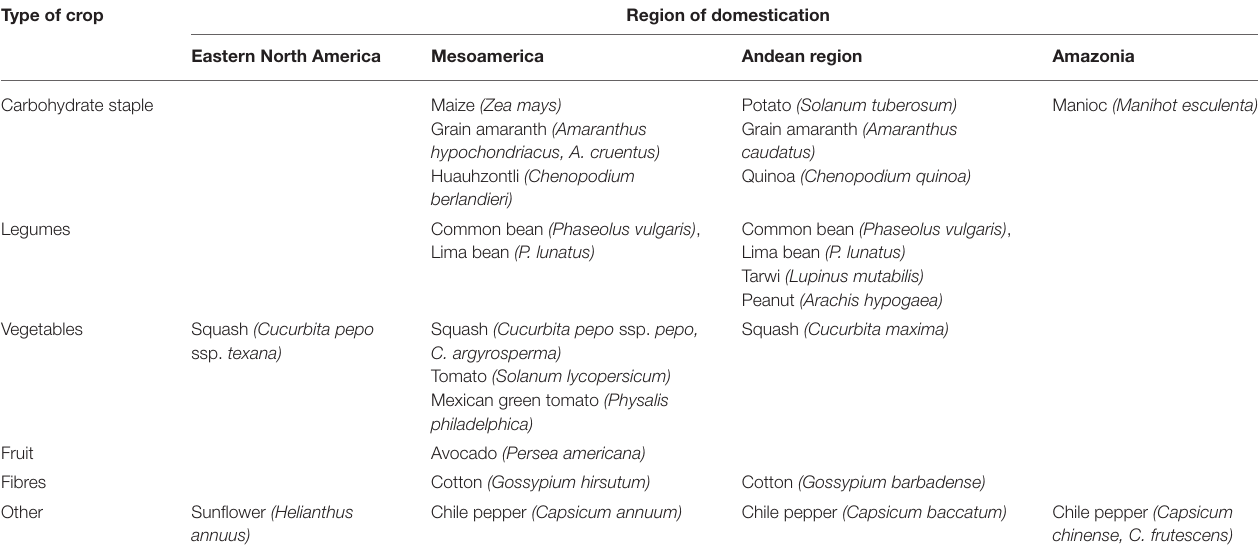
TABLE 2 | Principal regions of crop domestication in the Americas, with probable regions of domestication of those species mentioned in the